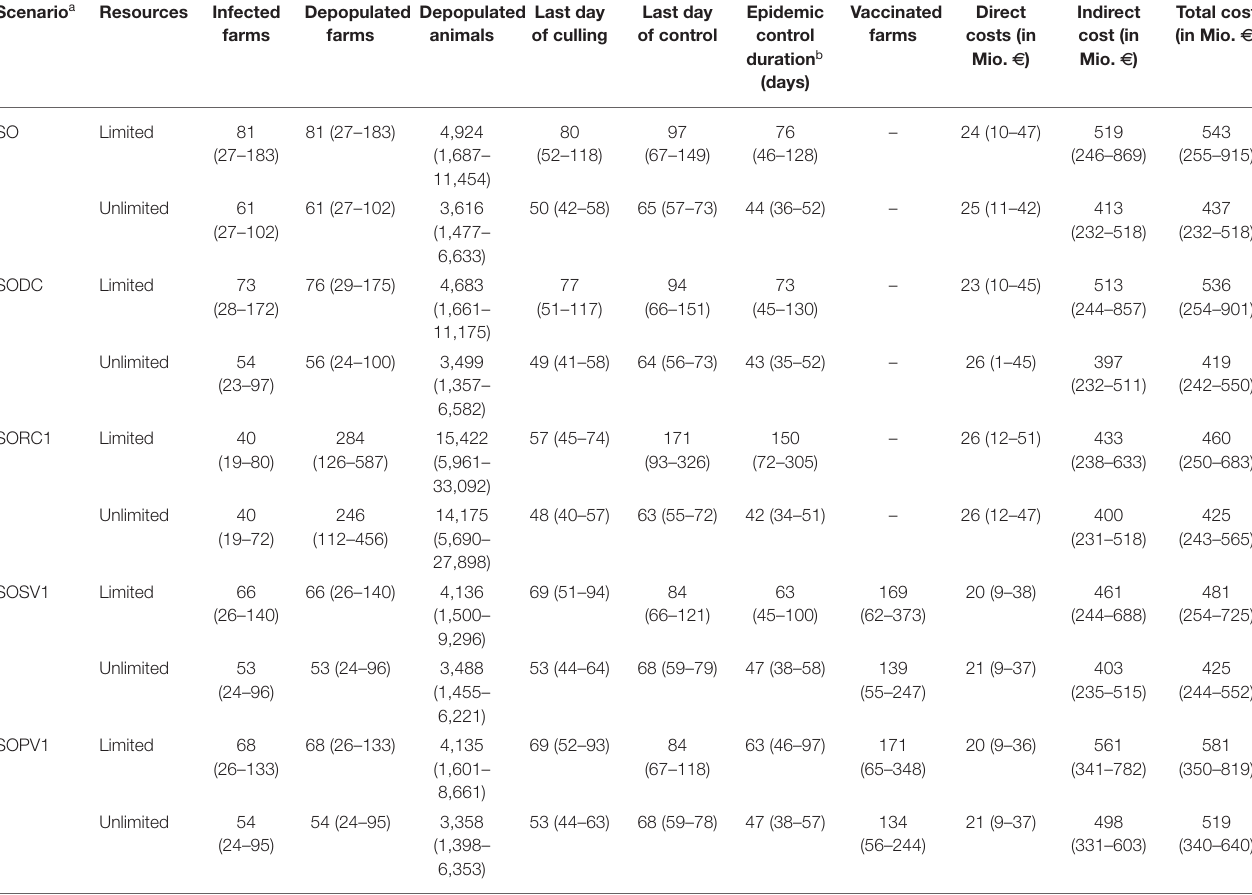
TABLE 1 | Comparison of epidemiological and economic results of simulations with limited and unlimited human resources. Scenario a Resources